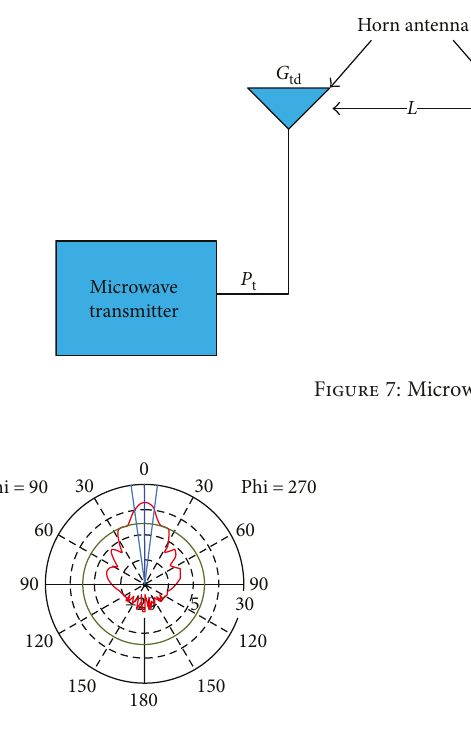
Figure 8: Radiation pattern of the pyramidal horn antenna.